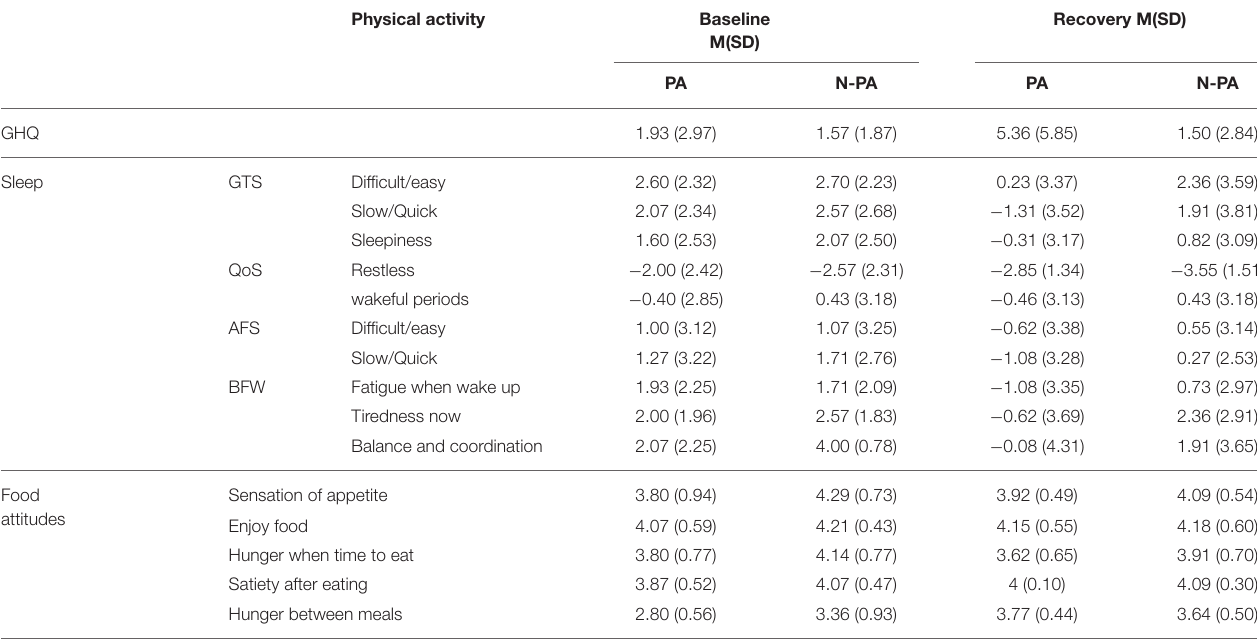
TABLE 4 | Health variables description (Mean; Standard deviation).